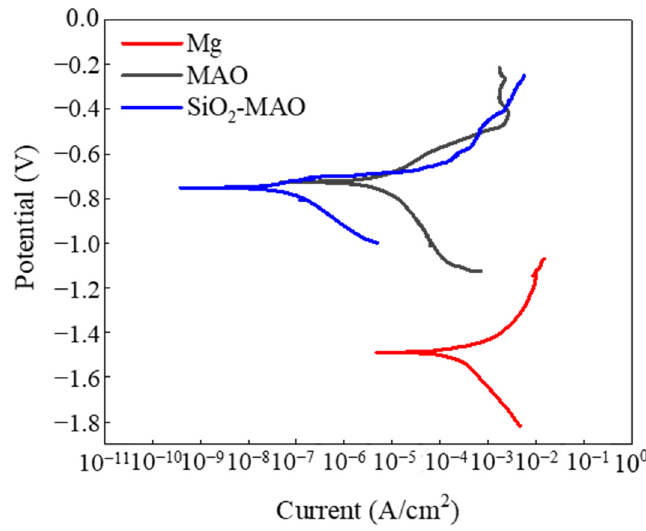
Figure 7. PDP curve of the